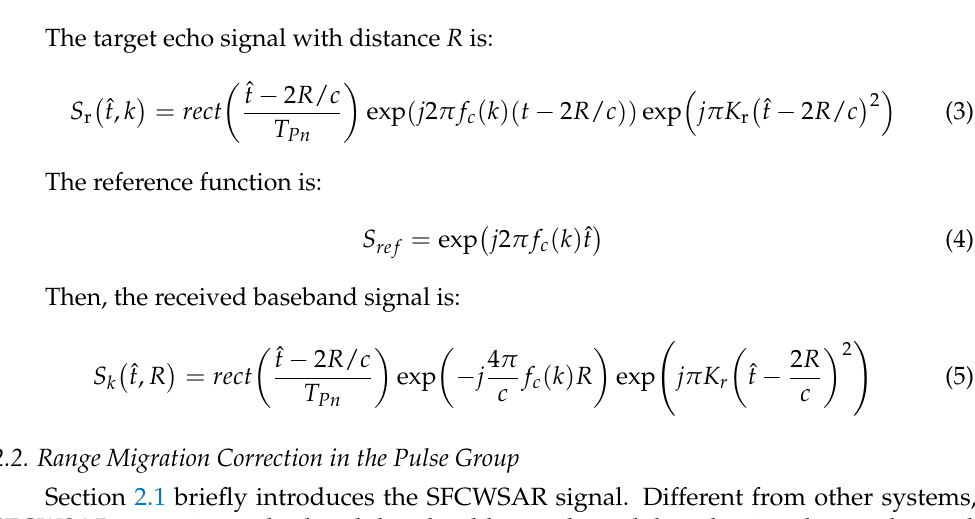
Figure 1. Pulse waveform of the Stepped Frequency Continuous